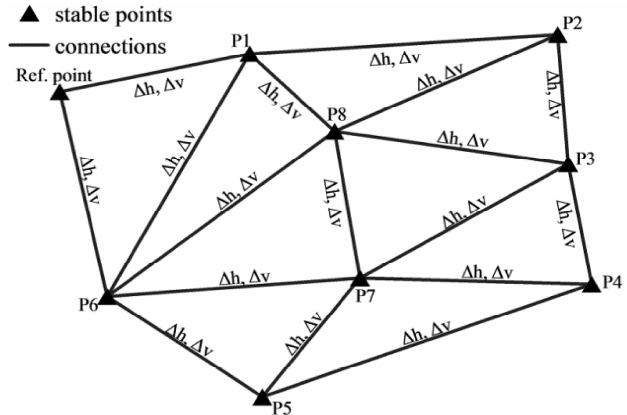
Figure 7. Triangulation network between stable points for atmospheric phase screen calculation. The differences are integrated across the graph in order to calculate the height and displacement values of each node. It was chosen here to connect points with ASI 1- sigma/mu ≥ 0.8, based on the assumption that this value indicates points that are stable enough in time. Figure 8 illustrates the triangulation network based on the selected persistent scatterer candidate points (PSC).